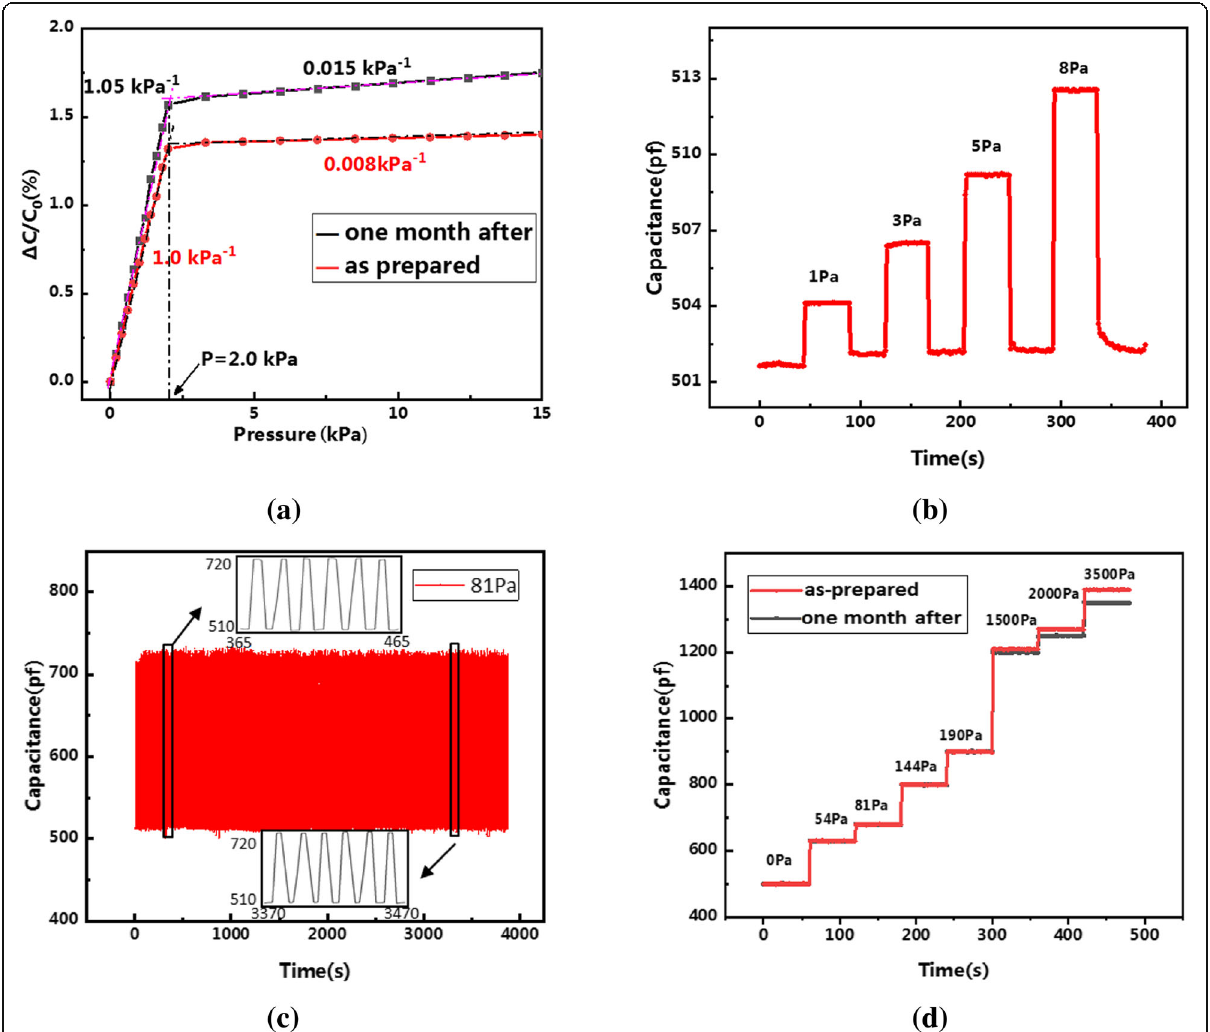
Fig. 4 Response test of AgNW-paper-based capacitive FPS: a pressure-capacitance relations within a large pressure range, b response at low pressure, c repetitive test in short duration, and d aging performance after one